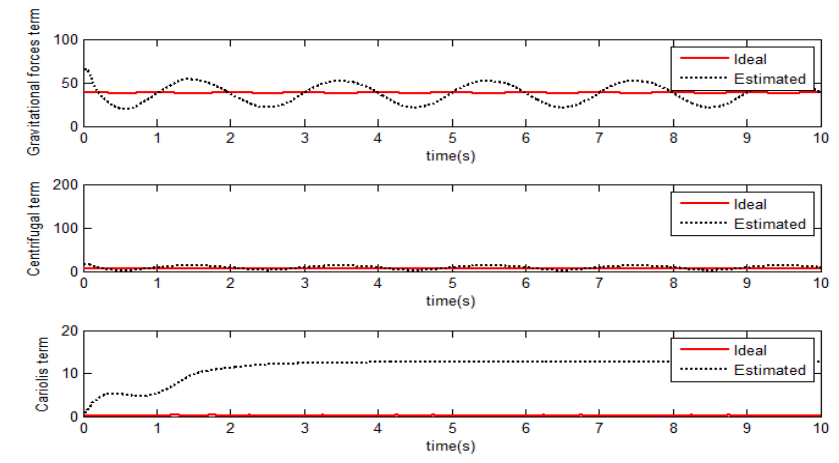
Figure 10. Estimation of dynamic system terms.